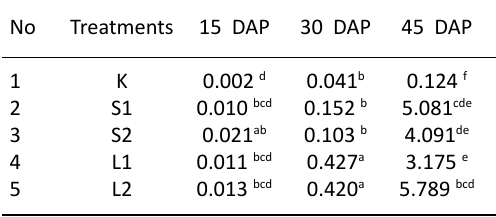
Table 2 . Dry weight of plants (g) treated by induced compost of cellulolytic and ligninolytic fungi inoculum